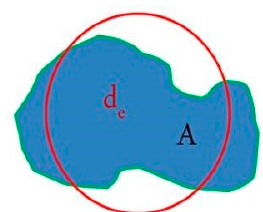
Figure 2. Definition of equivalent circle diameter.